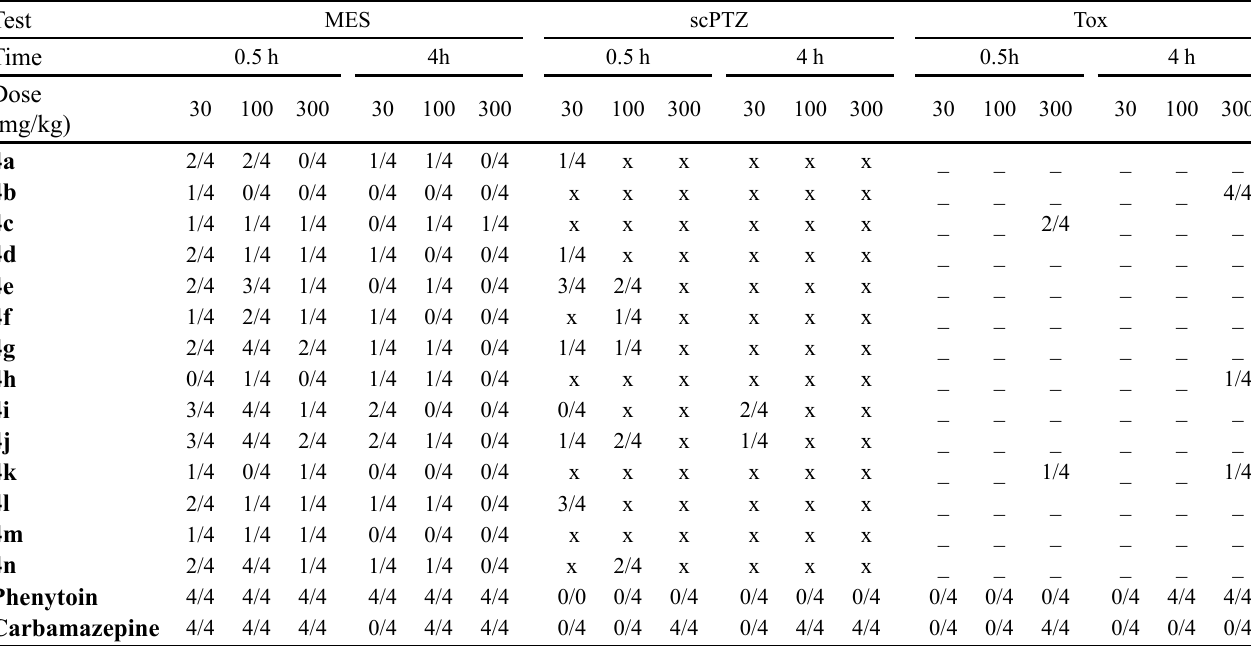
TABLE II - Anticonvulsant activity and neurotoxicity screening of compounds ( 4a - n ). Test MES scPTZ Tox Time 0.5 h Dose